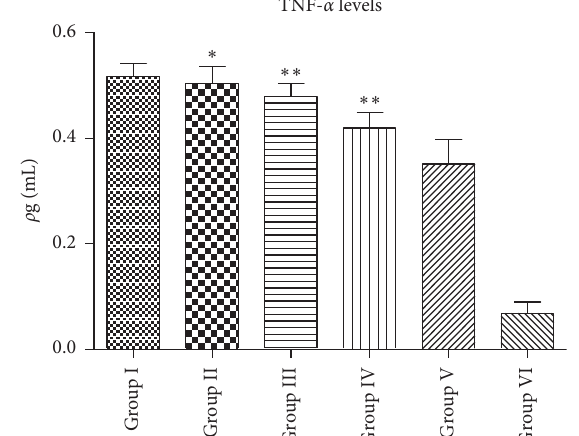
Figure 4: The plasma TNF- α levels (Group I � negative control, Group II � EA200, Group III � EA300, Group IV � EA400, Group V � positive control, and Group VI � normal control; data are presented as mean ± SEM), ∗ p > 0 . 05 vs. Group I; ∗∗ p < 0 . 05 vs. Group I. Table 2: MIC value of E. alba rhizome extract.